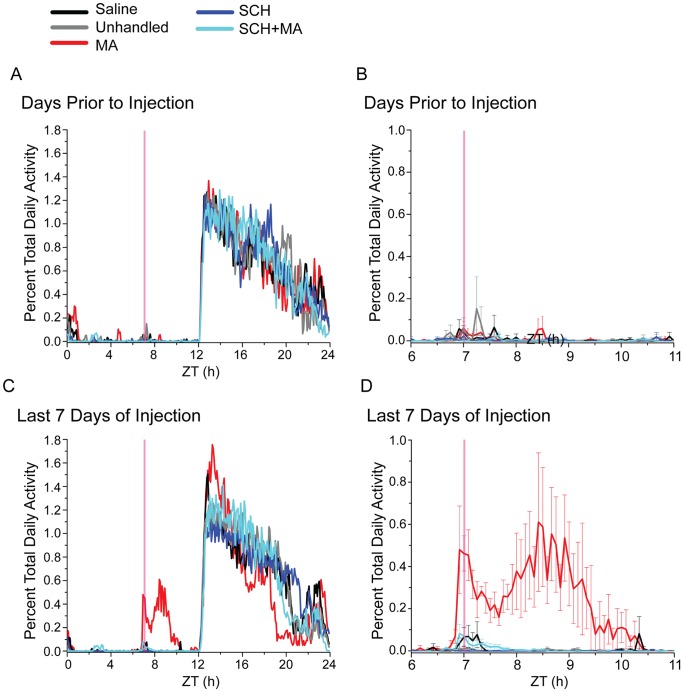
Average activity profiles from mice receiving scheduled daily saline (black), left unhandled (gray), receiving scheduled daily MA (2 mg/kg) injections (MA, red), receiving daily D1 receptor antagonist injections (SCH, blue), and receiving pretreatment with a D1 receptor antagonist followed by MA (SCH+MA, aqua).Activity data are averaged from 5 min bins across days 4 days prior to the start of injections (day −5 to −2, where day 0 is the first day of injections; Fig. 2A and 2B) or the last 7 days of injections (day 3 to 9; Fig. 2C and 2D). Data are expressed as percent of total daily activity, and zeitgeber time (ZT) is along the x-axis. The time of MA injection (ZT7) is indicated by the pink vertical line. A) and B) illustrate the full 24h activity profiles, plotted as the mean percent of total daily activity. C) and D) are enlarged data from ZT6-11, plotted as the mean ± SEM percent of total daily activity. Note the robust increase in activity level beginning immediately prior to and extending for 3–4h hours following injection in the MA group (D).